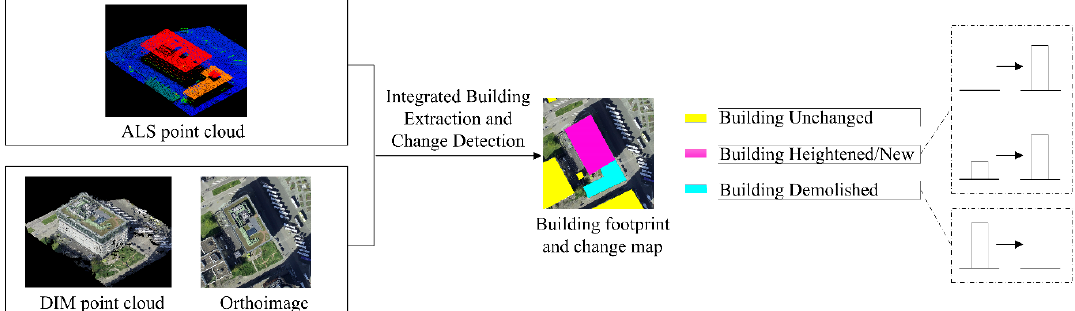
Figure 1. Overview of the input and output of the proposed method.